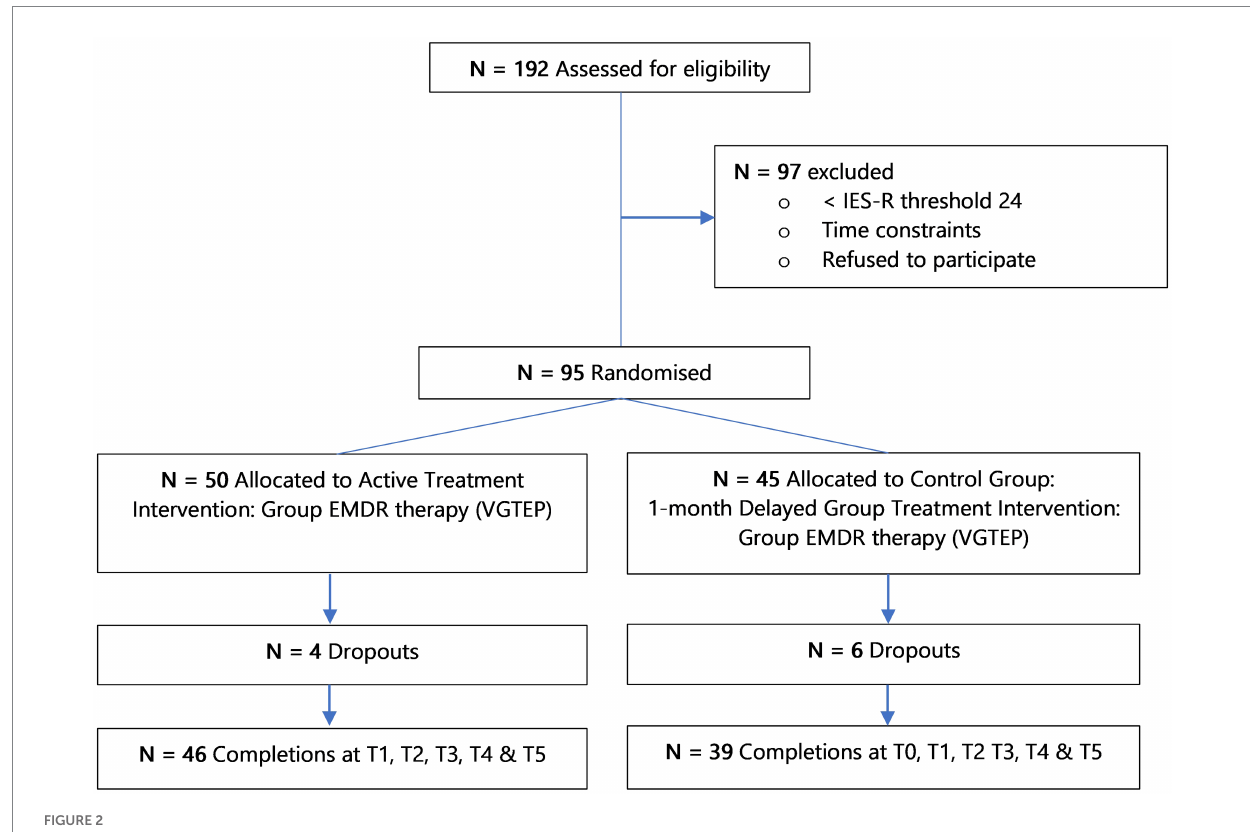
FIGURE 2 Flow of participants through the research clinical